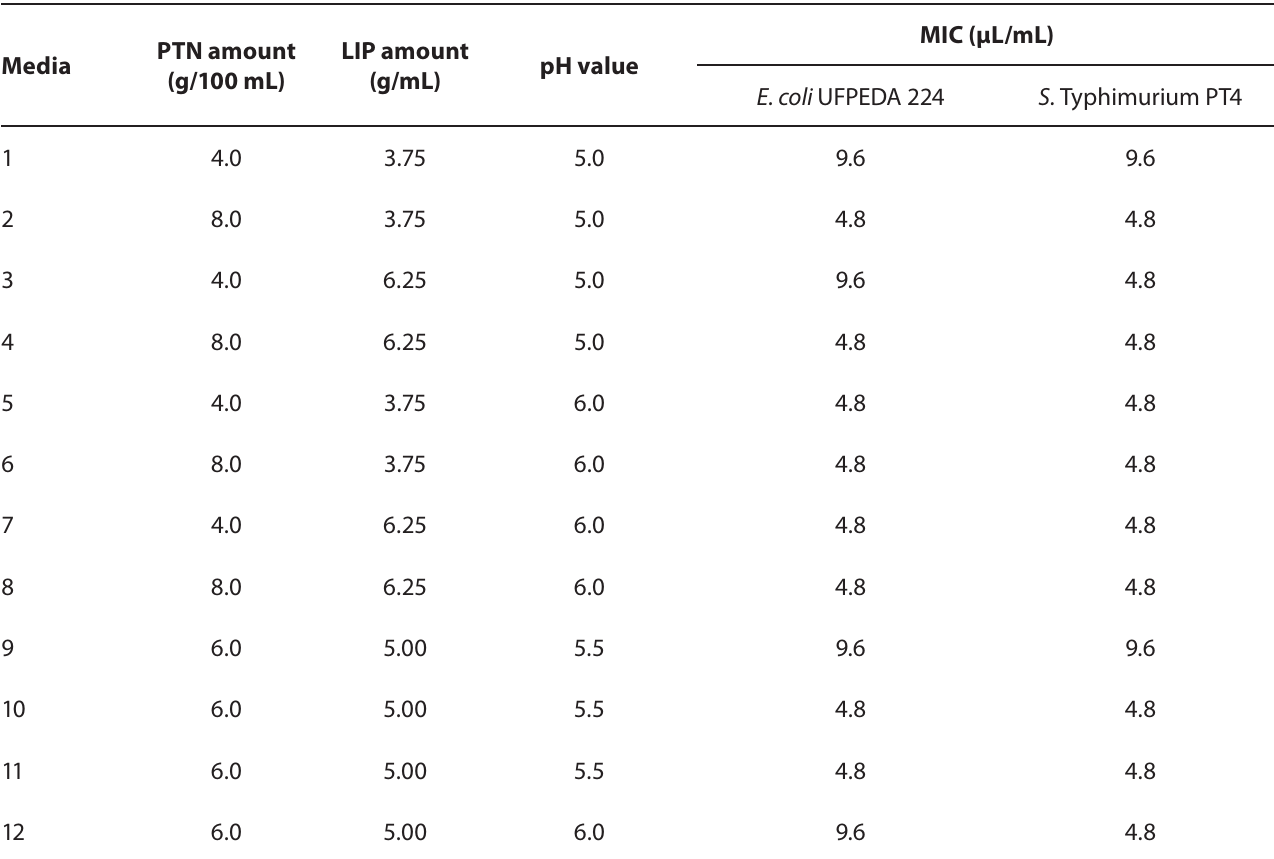
TABLE I - M inimum inhibitory concentration (MIC) of Origanum vulgare L. essential oil against Escherichia coli UFPEDA 224 and Salmonella Typhimurium PT4 in media with different amounts of proteins, lipids and pH